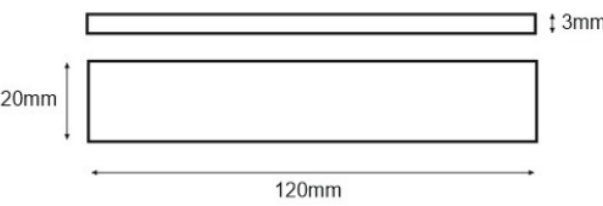
Figure 4. Tensile test specimen.